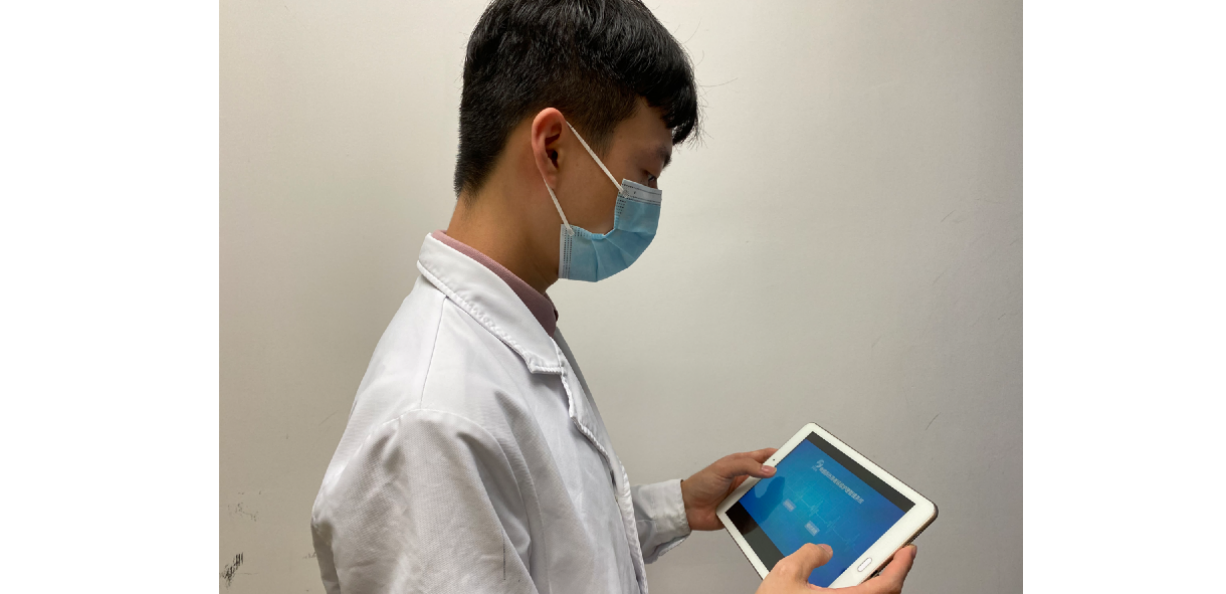
Figure 3. An occupational therapist using the